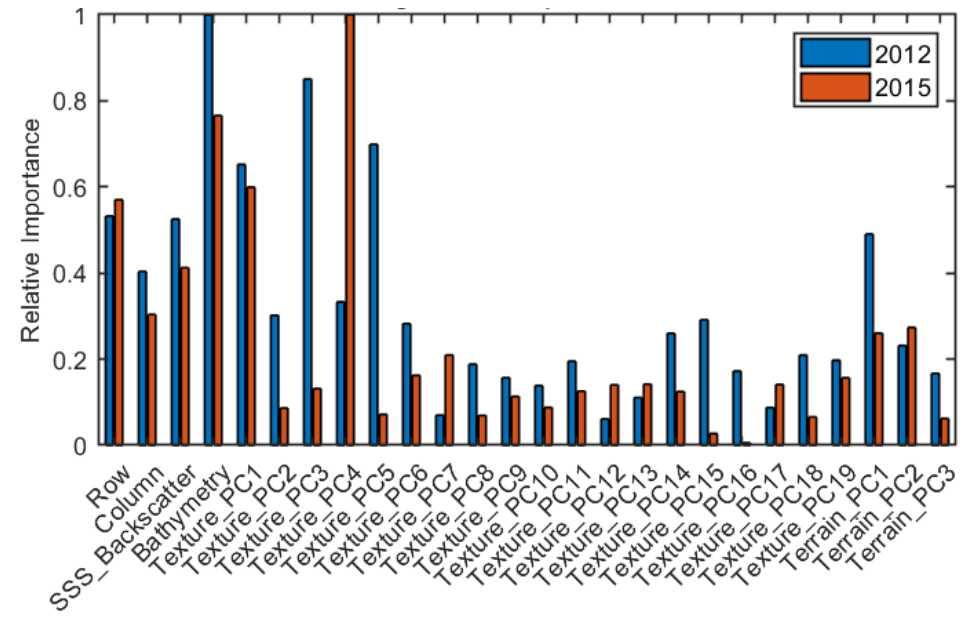
Figure 12. Estimated feature importance in the 2012 and 2015 Random Forest (RF) models. Calculated by out-of-bag permutation of features by RF algorithm.